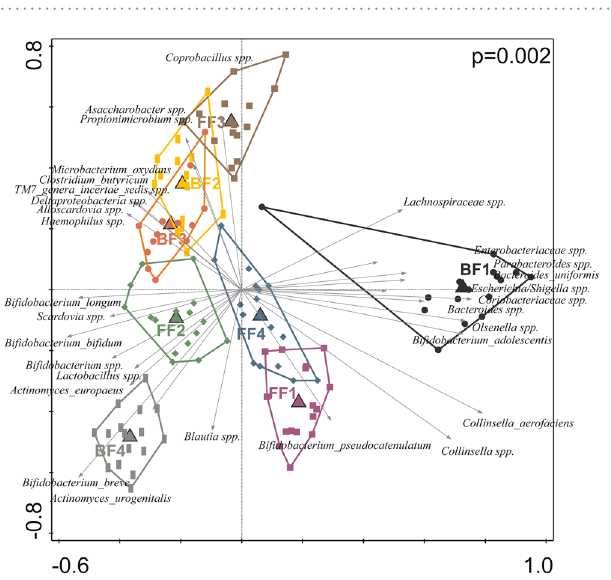
Figure 1. Principal component analysis (PCA) based on the species level gut microbiota composition of breast and formula-fed infants from day 1 to 12 weeks of age. Nominal environmental variables are indicated by large down triangles (infants: BF1-4 and FF1-4), small down triangles (time points: D1-D84) and stars (diet: formula and breast). Reads that could not be assigned on the species level were included on the genus (genus unspecified) or family level (family unspecified) depending on the phylogenetic resolution. Reads were always assigned to the most specific taxonomic level possible, taxa that could not be assigned on the species level were included as genera or families unspecified.